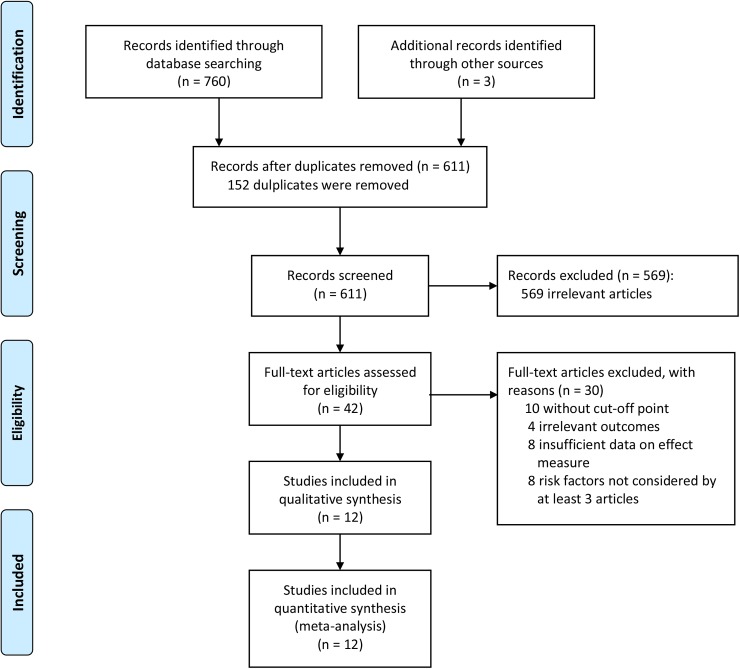
Flowchart of search and selection process for eligible studies.